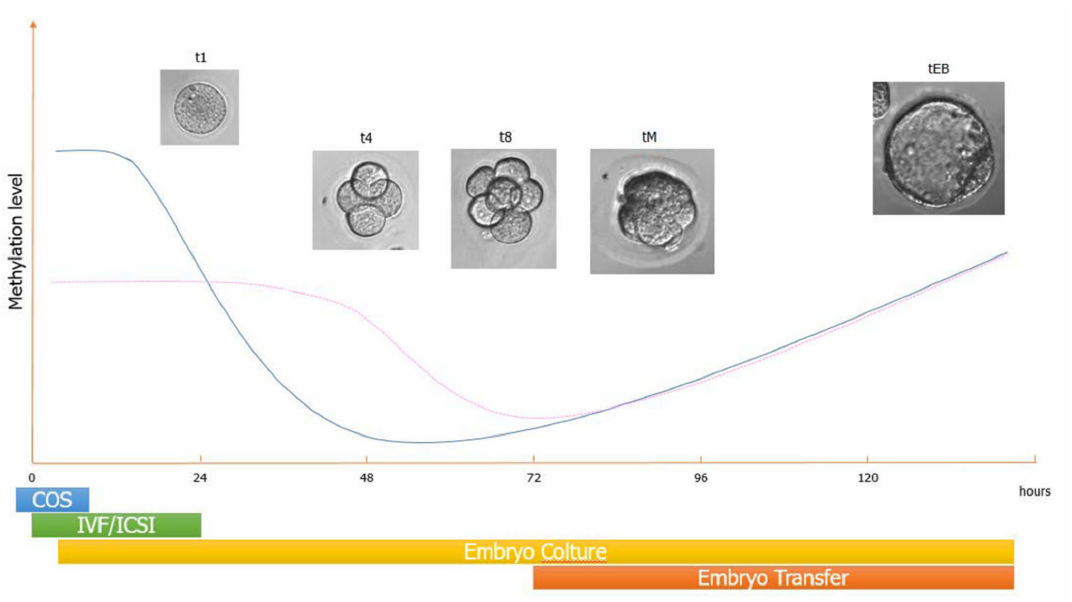
Figure 7. Timing of the methylation pattern of paternal and maternal alleles during human embryo- genesis. After fertilization, the embryo undergoes the first wave of global demethylation, followed by de novo methylation. Only the imprinted genes escape epigenetic reprogramming. The timing of these events is concomitant with that of in vitro fertilization (IVF), intracytoplasmic sperm injection (ICSI), embryo culture, and embryo transfer. COS controlled ovarian